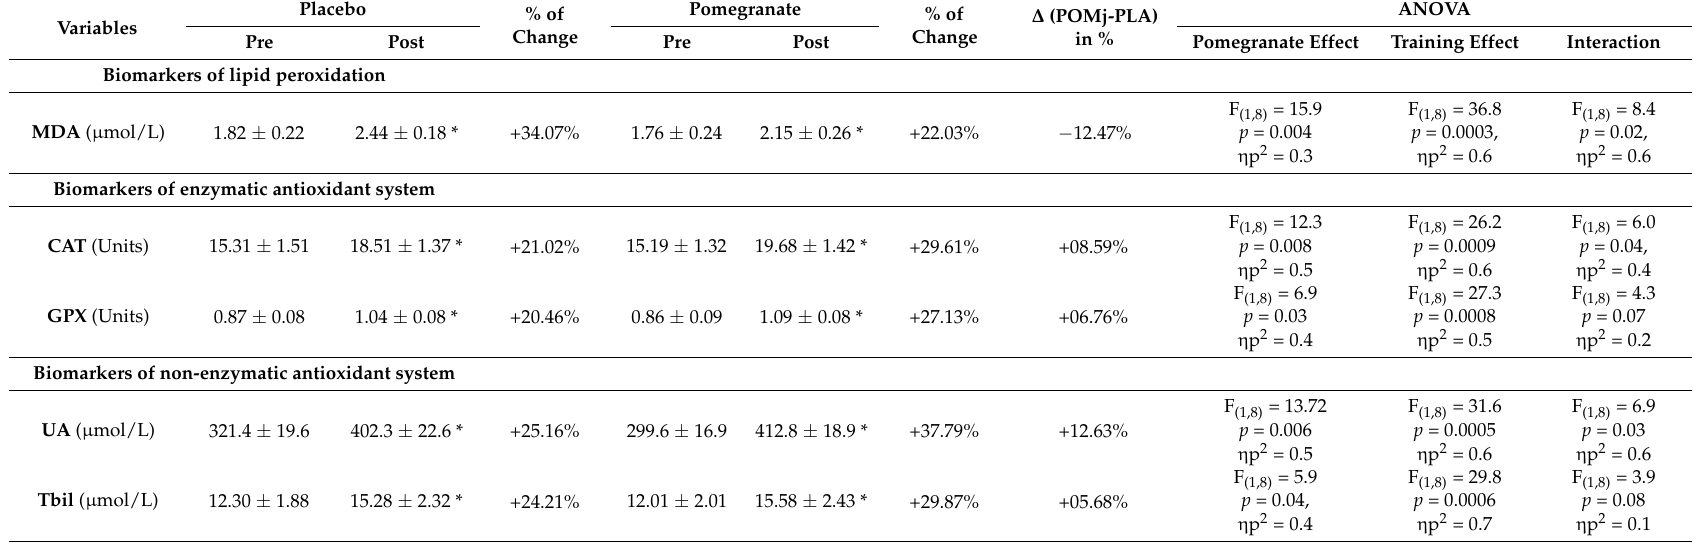
Table 1. Acute oxidative stress responses to weightlifting training session following pomegranate juice (POMj) and placebo (PLA) supplementation.